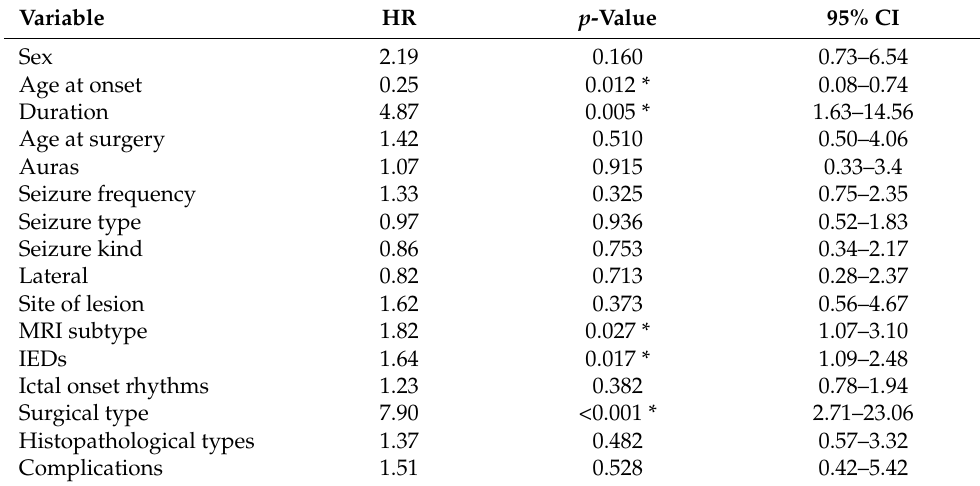
Table A3. Independent variables in the univariable Cox regression